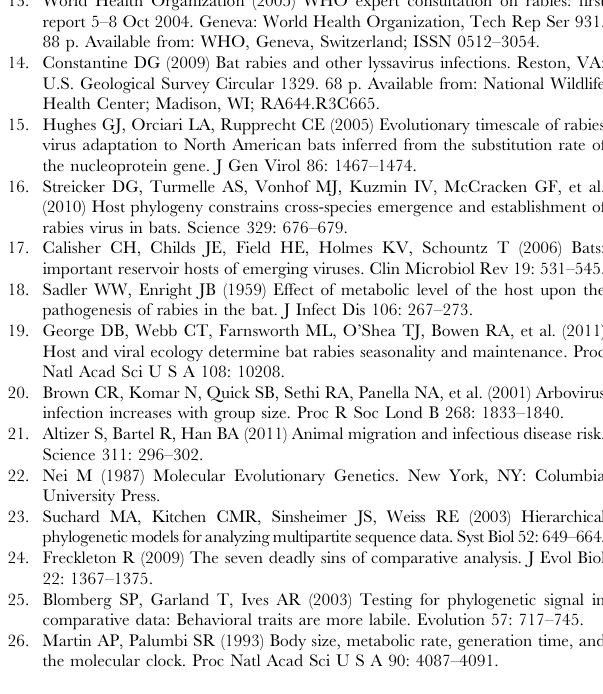
Table S6 Evolutionary rate estimates by codon partition for independent lineage models. Numbers in parentheses are the 95% highest posterior density around the median rate. Table S7 Evolutionary rate estimates by codon partition from the hierarchical phylogenetic model. Numbers in parentheses are the 95% highest posterior density around the median rate and were calculated conditionally on the portion of the posterior distribution for which the significant effect (climatic region) was included in the model (i.e., b i | d Effect i =